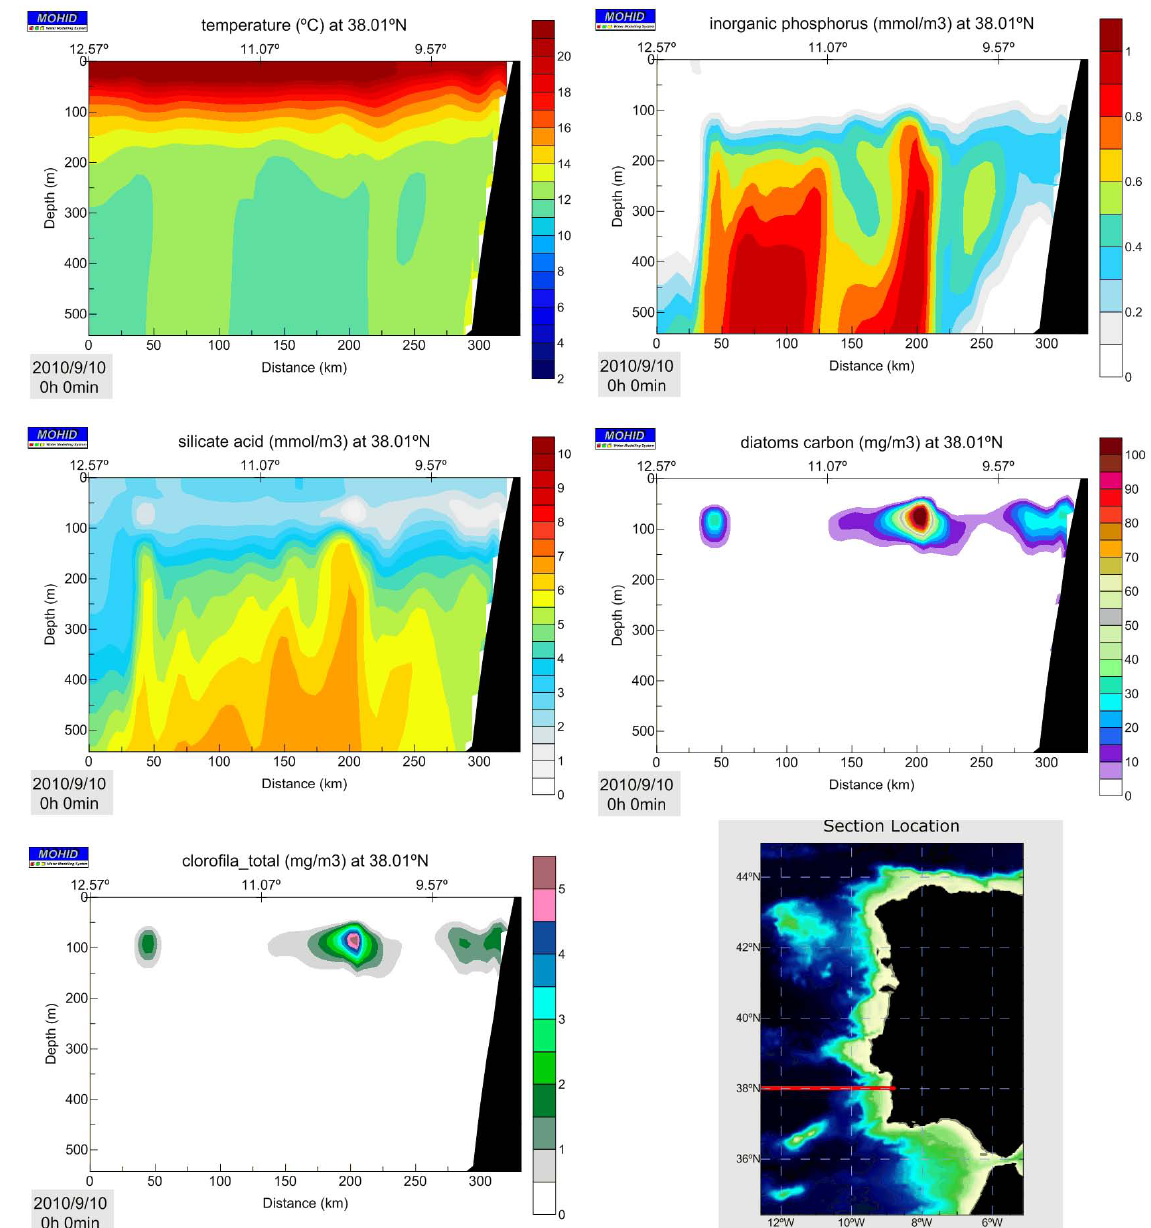
Fig. 14. Zonal section of the south-western coast of Portugal, showing the vertical structure for some properties from the MOHID-PCOMS model coupled with one of the ecological models available in the MOHID. The section location is represented by the red line.